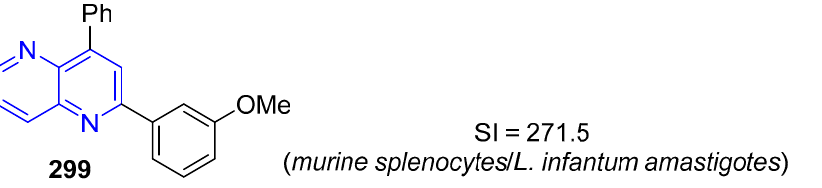
Figure 23. 1,5-Naphthyridine derivative with antileishmanial activity.